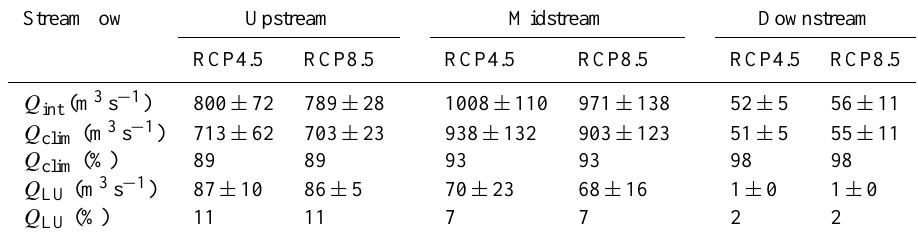
Table 7. Contribution of LU and climate to streamflow during the T1 (2010–2020) time slice under RCP4.5 and RCP8.5 emission scenarios.